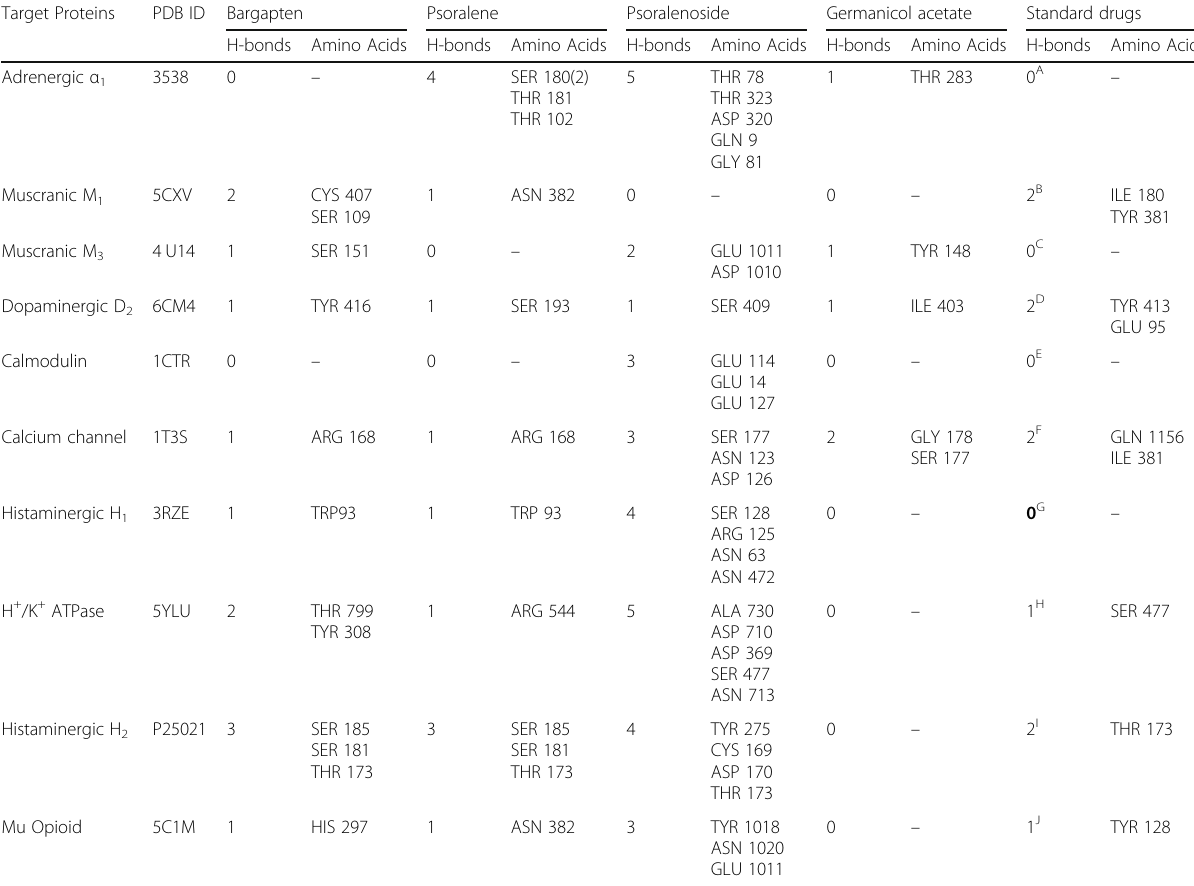
Table 5 Hydrogen bonds (H-bonds) formed by bergapten, psoralene, psoralenoside, germanicol acetate and standard drugs